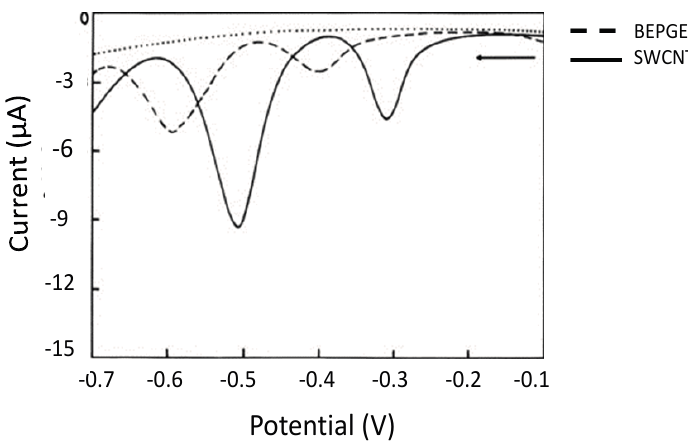
Figure 4. SWV of Gua and 8-hydroxyGua at ( a ) bare edge plane pyrolytic graphite electrode (BEPGE) and ( b ) SWCNT modified EPPGE; the dotted line is SWV of blank PBS using SWCNT/EPPGE at pH 7.2. Reproduced from [124] with